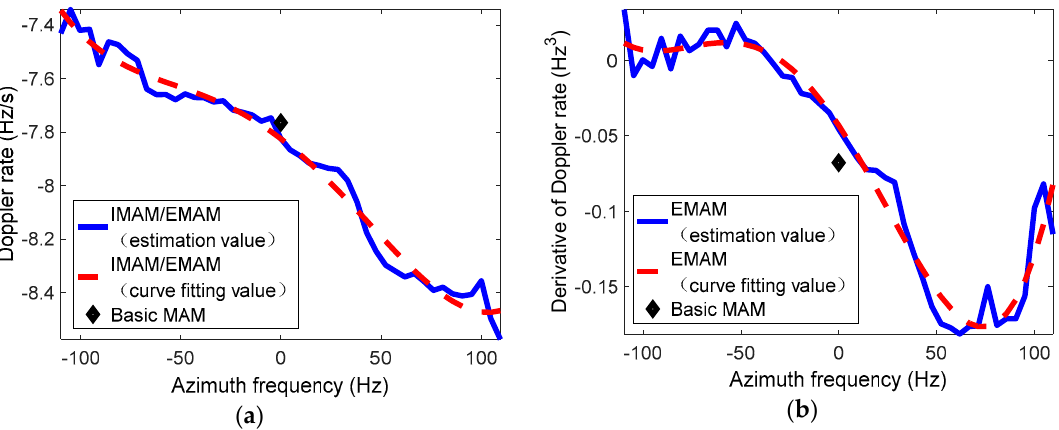
Figure 13. The estimation curves of the spatially-variant Doppler parameters based on the different methods. ( a ) The Doppler rate; ( b ) the derivative of the Doppler rate.